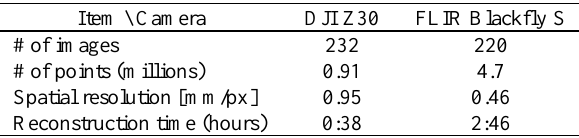
Table 2. 3D reconstructions result for segmented virtual